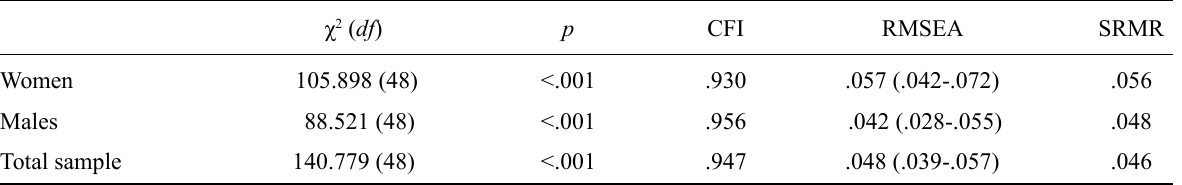
Global Model Fit for Female, Male, and Total Samples